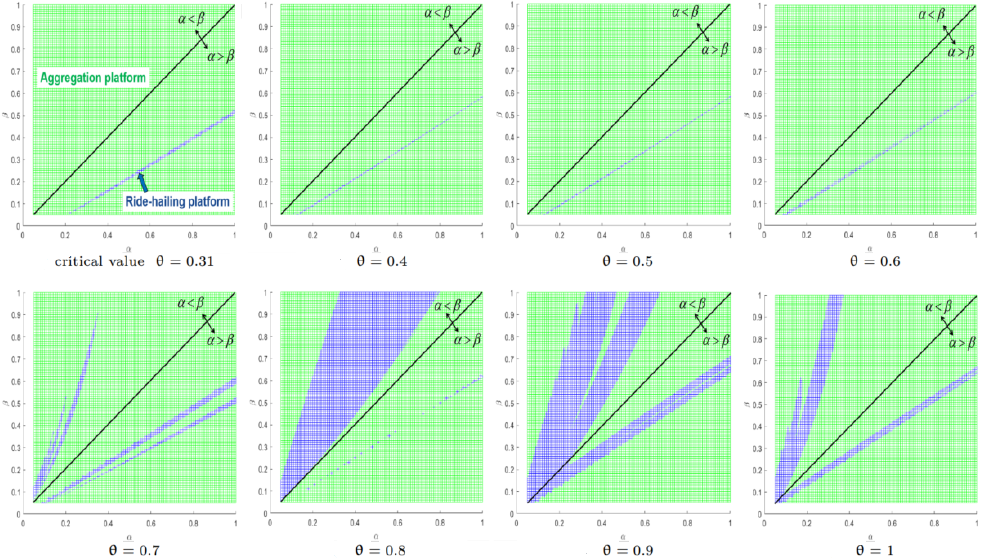
Figure 11. The profits in Model N and platforms’ best α and β in Model B.